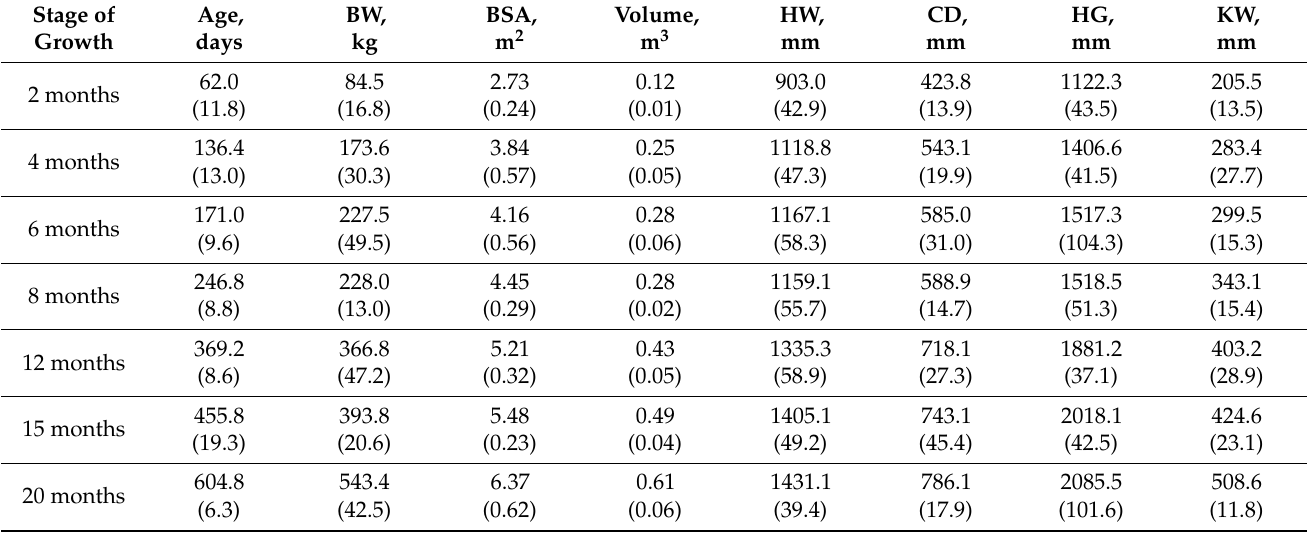
Table 3. Mean and standard deviation (in brackets) of selected morphological traits, surface area, and volume estimated from 3D images of five growing heifers at different stages of growth. BW was recorded using a weighing